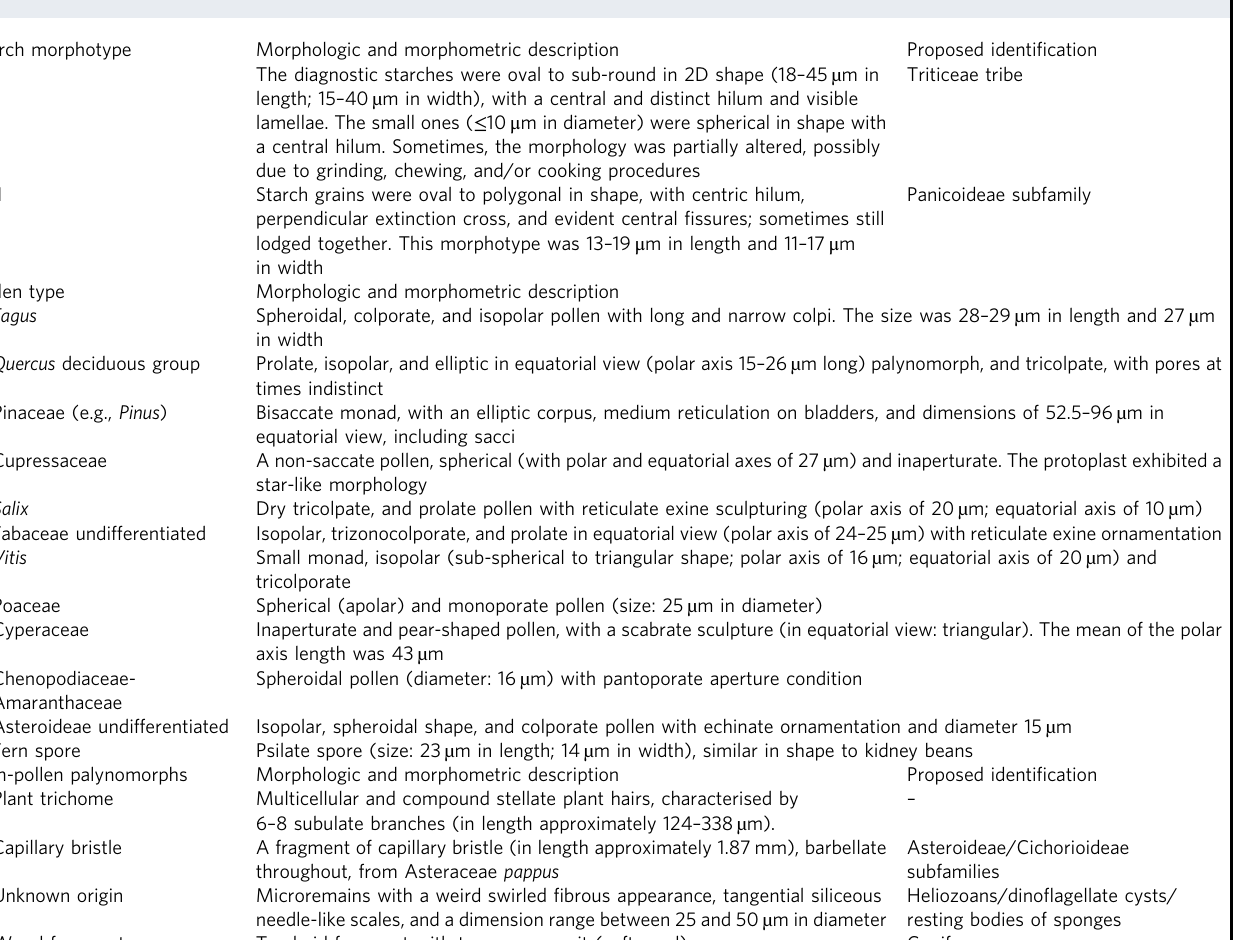
Table 1 Proposed identi fi cation for microparticles observed in ancient dental